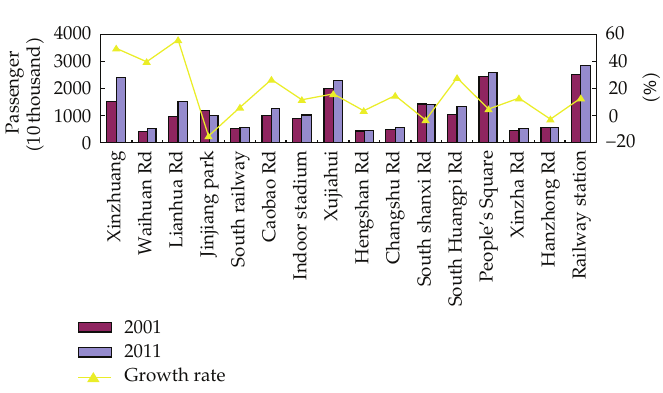
Figure 3: Growth rate of passenger flow of line 1.